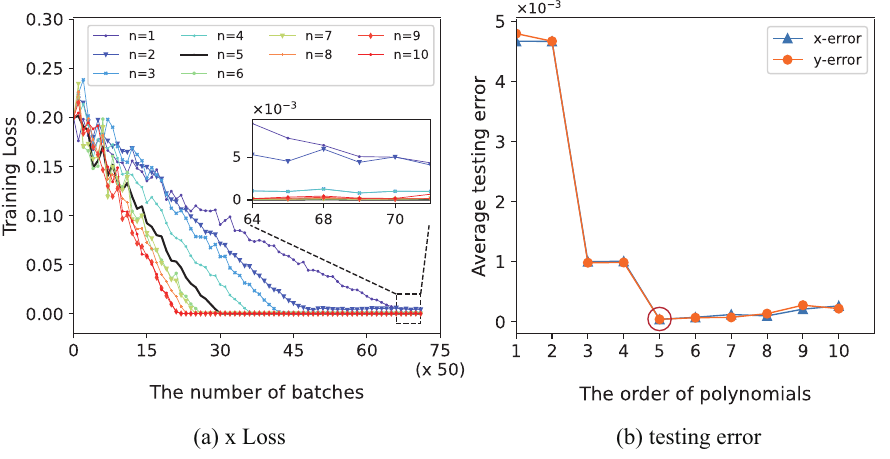
Figure 6. The training loss and the average testing error for different orders of the 2D Legendre neural network: ( a ) the training loss at x -axis direction and ( b ) the average testing error at x -axis and y -axis direction. The optimum order should be the black curve in diagram ( a ) and the red circle in diagram ( b